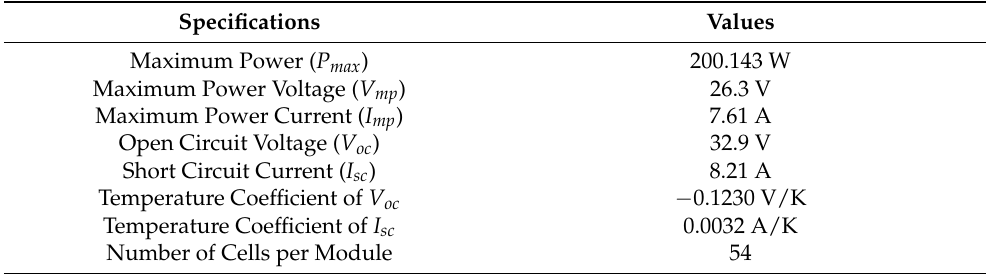
Table 1. Kyocera KC200GT 200 W.